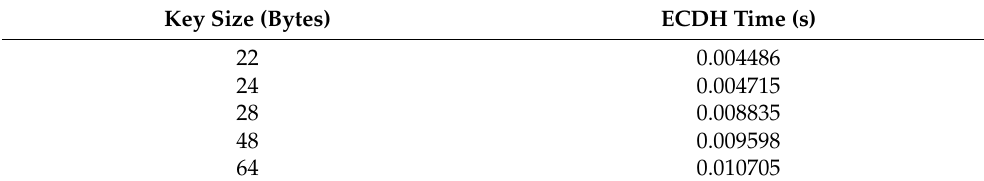
Table 5. ECDH times in relation to key size.